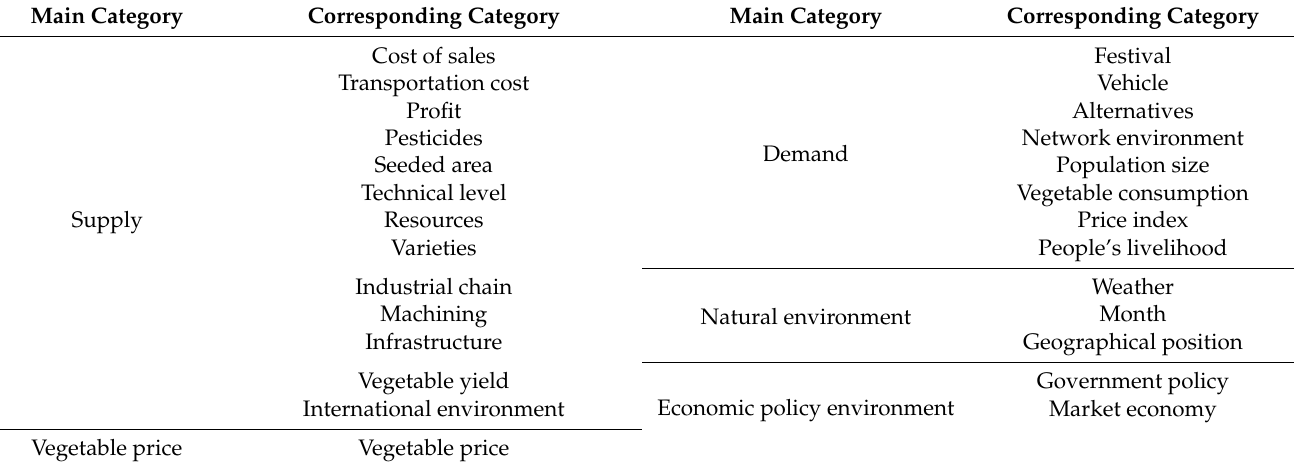
Table 4. Spindle coding results.